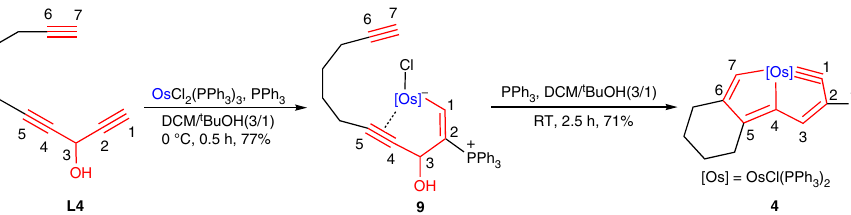
Fig. 8 Isolation of the key intermediate. Isolation of the alkynyl-coordinated osmium vinyl intermediate 9 and its transformation to CCC-type osmium chelate 4